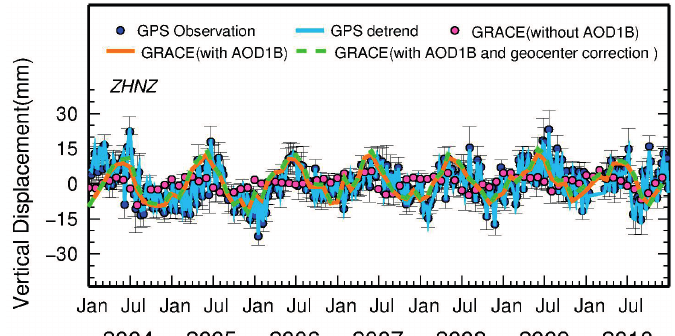
Figure 4. Vertical surface displacements (mm) derived from GPS observations and its detrended seasonal time series, and GRACE with or without AOD1B and geocenter correction, using ZHNZ GPS station as an